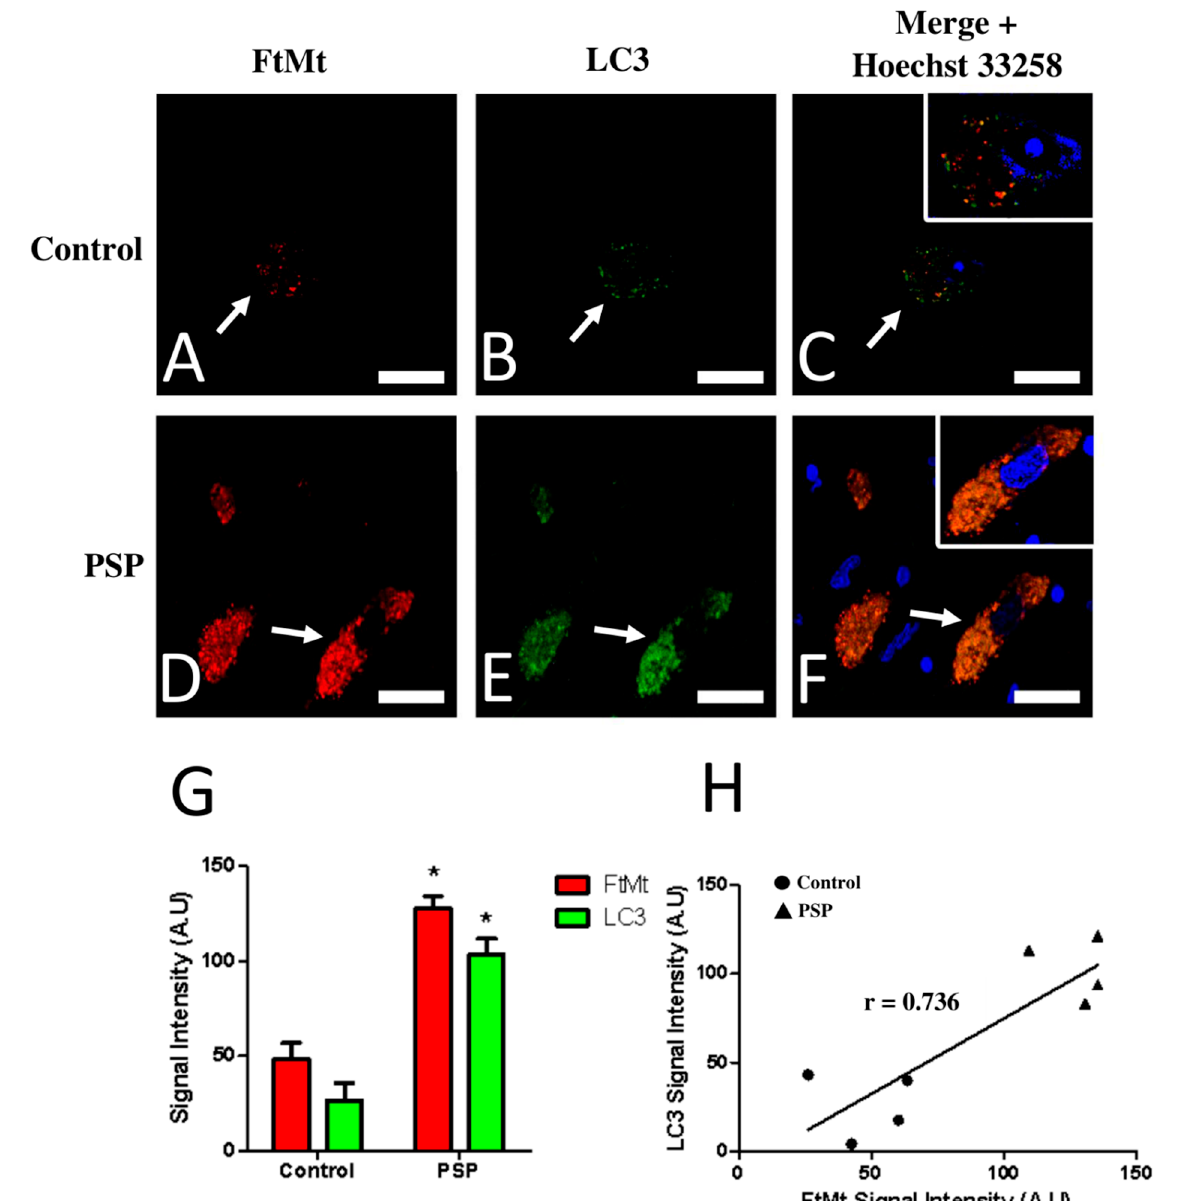
Figure 2. Confocal imaging ( A – F ) and quantitative analysis ( G , H ) of double immunofluorescence histochemistry for FtMt and LC3 in the SNc of a control case (control-1) and a PSP patient (PSP-4). Immunoreactive signal intensity of the control and PSP cases were quantified from 5 stacked images. ( A ) FtMt-IR in a control case’s SNc. The arrow indicates a neuron with weak FtMt-IR; staining was limited to puncta. ( B ) LC3-IR in a control case’s SNc. The arrow indicates a neuron showing weak LC3-IR; staining was limited to puncta. ( C ) Merged images ( A , B ). ( D ) FtMt-IR in a PSP case’s SNc. The arrow points at a neuron with strong FtMt-IR. ( E ) LC3-IR in a PSP case’s SNc. The arrow points at a neuron with strong FtMt-IR. ( F ) Merged images ( D , E ). Panels ( C , F ) contain an additional inset with vivid nuclei staining to illustrate the boundaries of the cell nucleus (magnification is the same as the main panel). ( G ) Quantitative signal intensity analysis for the FtMt-IR and LC3-IR in the SNcs of control and PSP cases. * indicates a significant difference ( p < 0.05) compared to the control cases. Data are presented as the mean ± standard error of the mean (SEM). ( H ) Plotted values of FtMt and LC3 immunofluorescence intensities. The coefficient of correlation (r) is indicated on the graph. Nuclei stained with Hoechst 33258 are shown in the merged images. All scale bars: 20 µm.